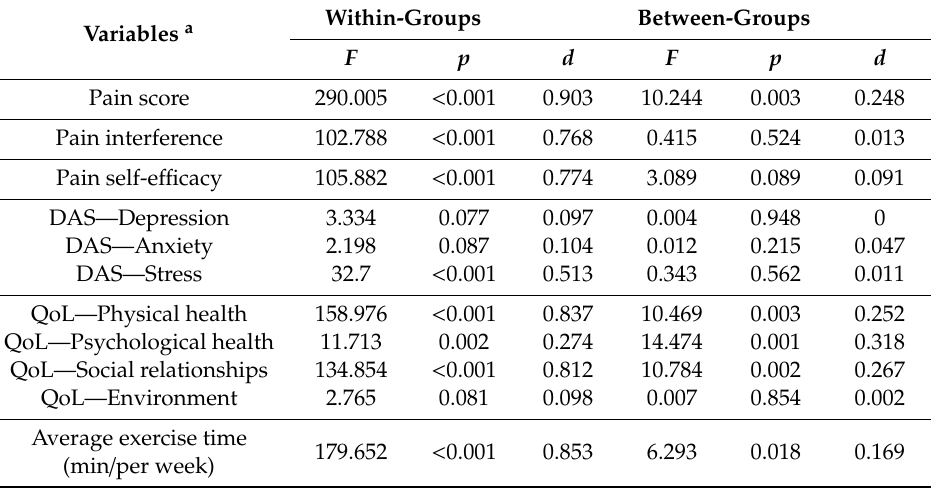
Table 3. Results of the repeated measures ANOVA for the outcome